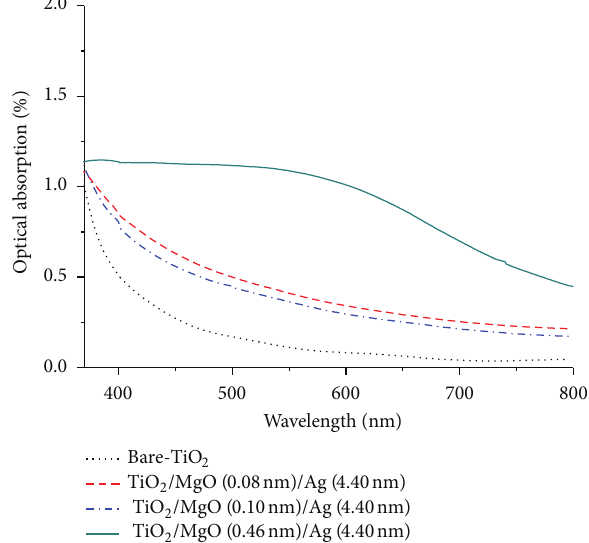
Figure 9: Optical absorption spectra of the TiO 2 /MgO/Ag compos- ite films with varied film thicknesses of magnesium oxide in range of 0.08–0.46